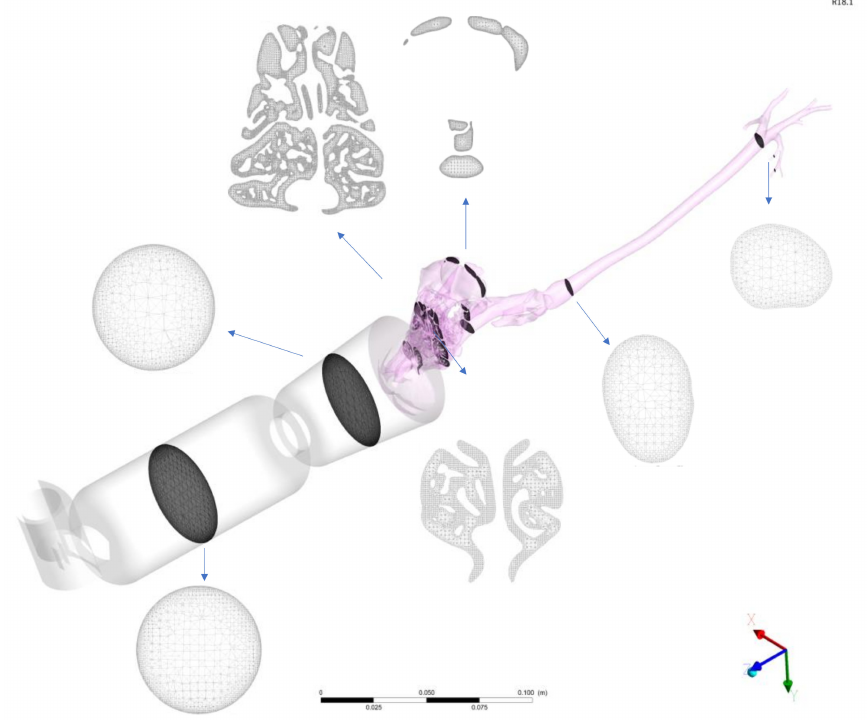
Figure 3. Representation of the numerical discretization in a non-intubated feline CT-based model of pressurized metered-dose inhaler (pMDI) drug delivery. The airways volumes are filled with three-dimensional elements (tetrahedrons). In this example, a pMDI is connected to a 10 cm spacer and a conical preoxygenation